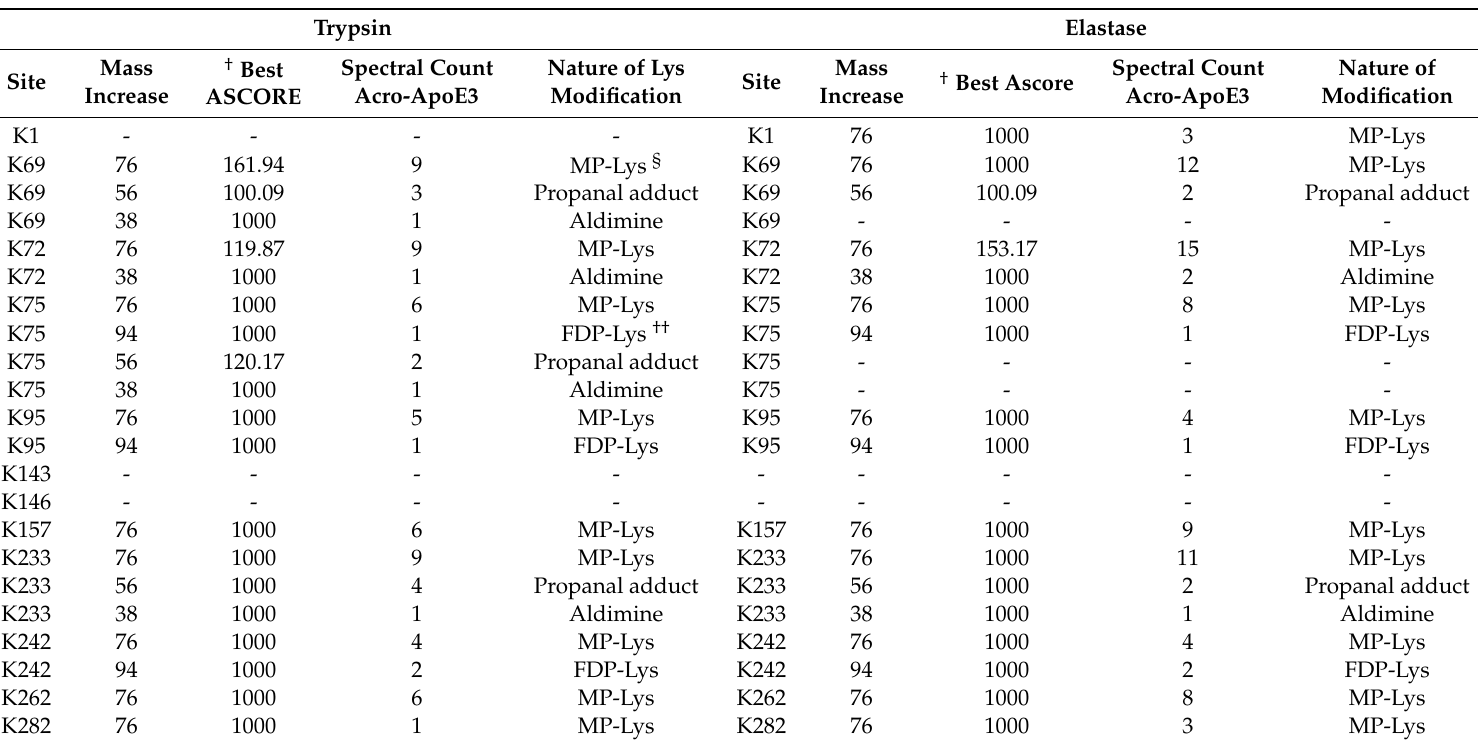
Table 1. Validated sites and nature of modification in acro-apoE3 following trypsin and elastase digestion and LC-MS / MS analysis